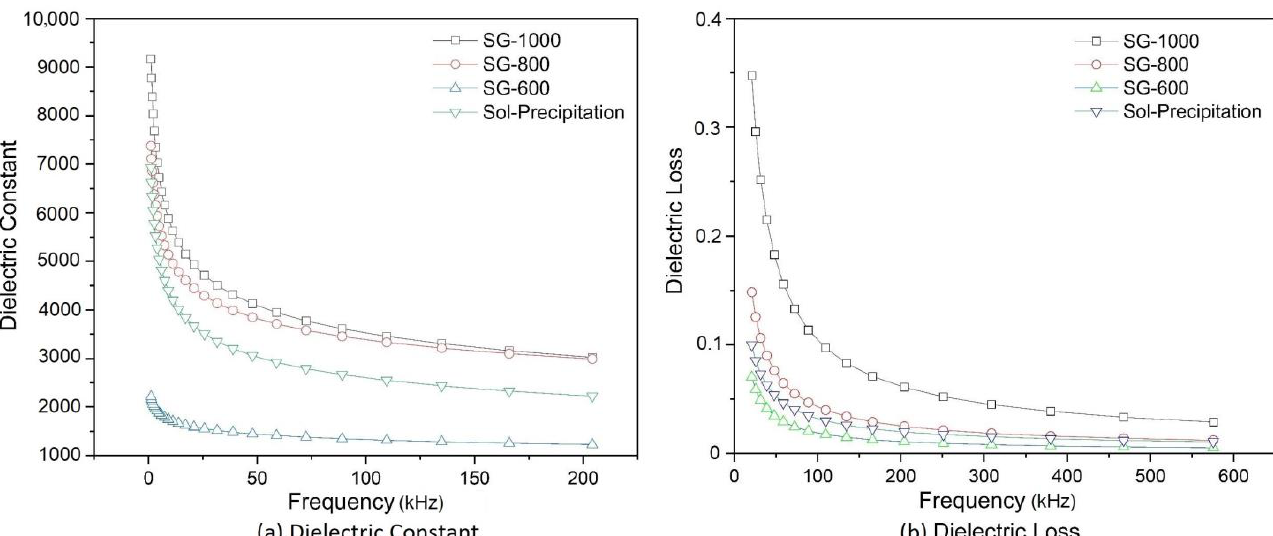
Table 4. Table comparing samples with the respective band gap energy, dielectric properties, te- tragonality factor and grain size at room temperature.